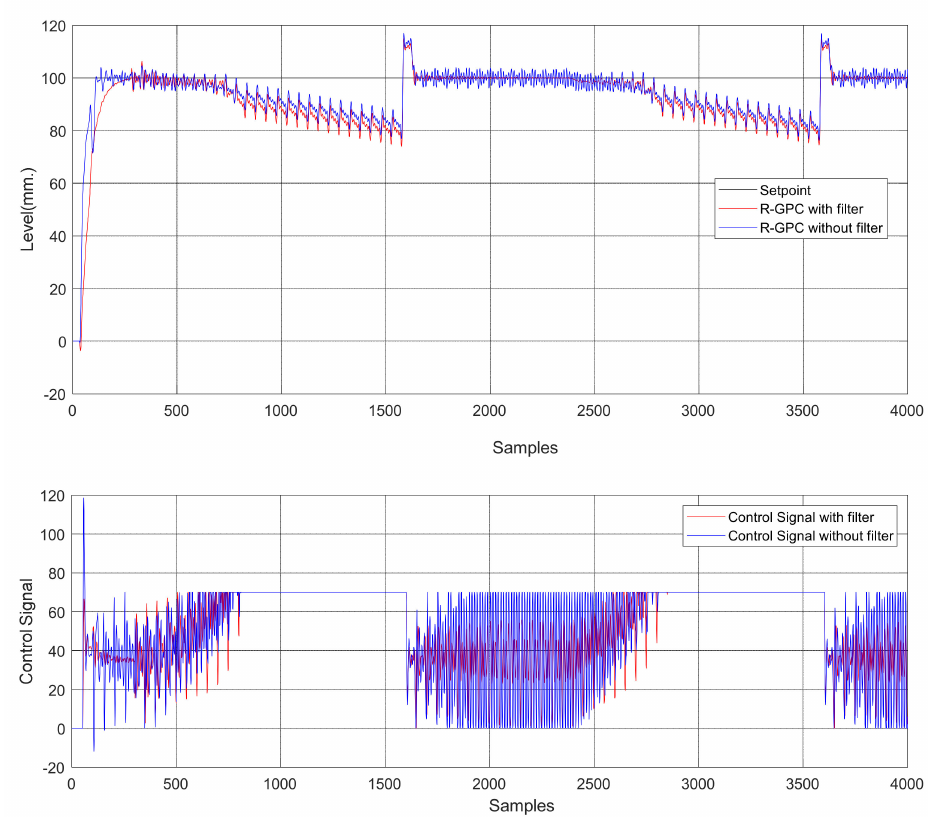
Figure 18. Comparison among the repetitive structures, with filter (red) and without filter (blue), with bulging and clogging/unclogging disturbances.